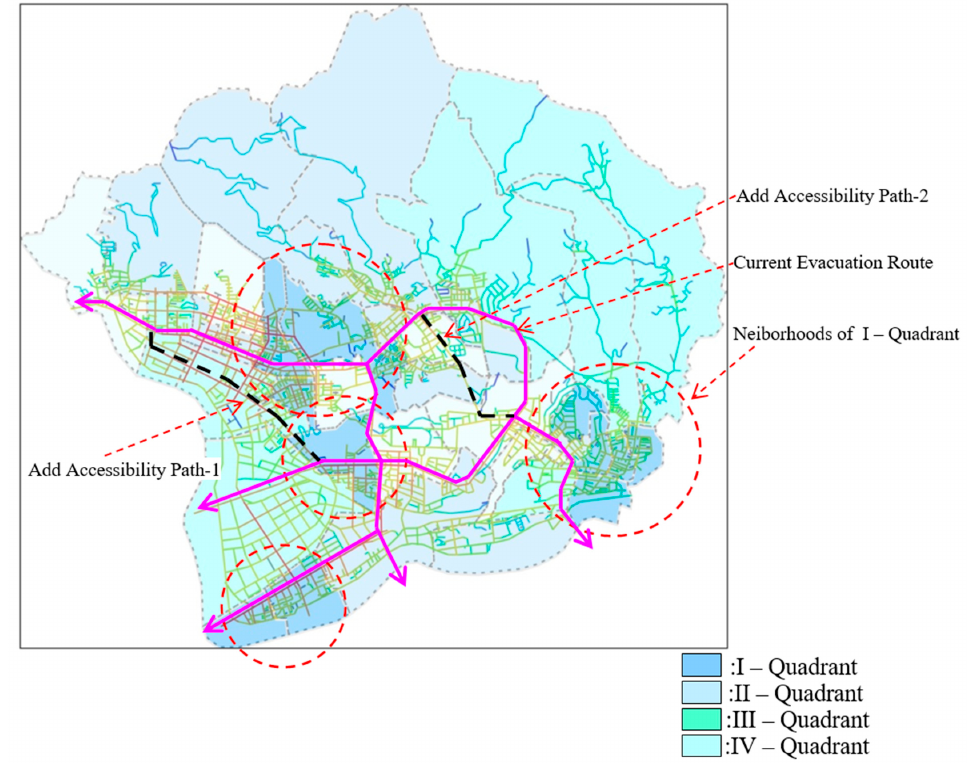
Figure 8. Comparison mapping of added accessibility path.